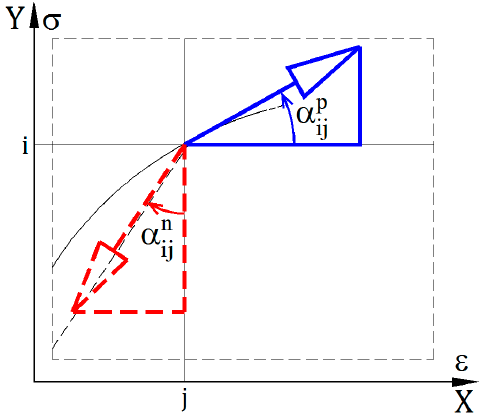
(cid:0) σ (cid:1) ε . i , j